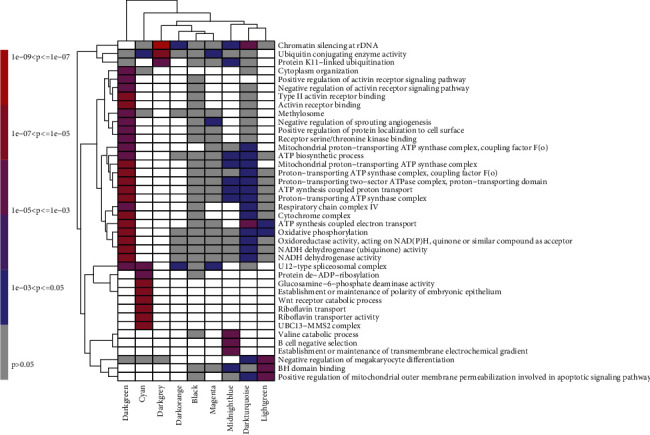
All modules rich factor summation sequence top 40 GO term enrichment heat map.